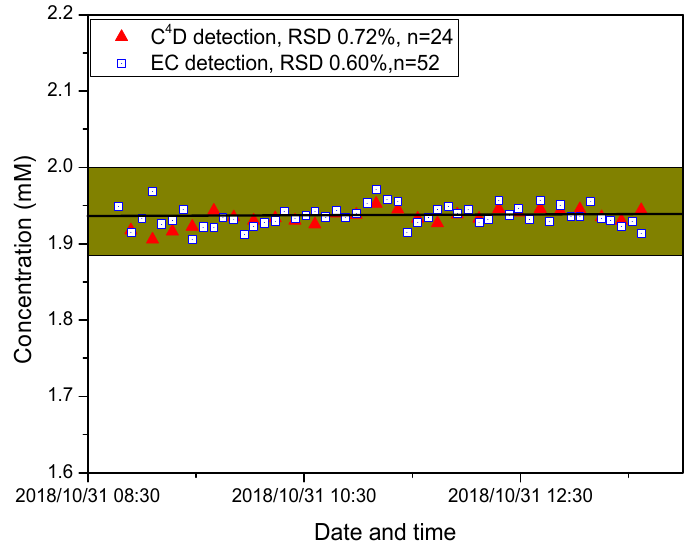
Figure 3. Comparison of DIC determination results with EC detection method and C4D detection method .